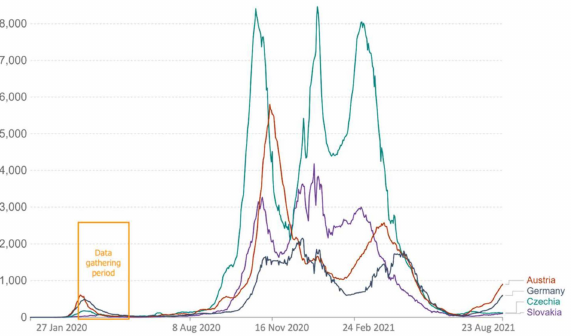
Figure 1. The weekly cases per million people in all four countries within the data gathering period. Source: Johns Hopkins University CSSE COVID-19 Data.